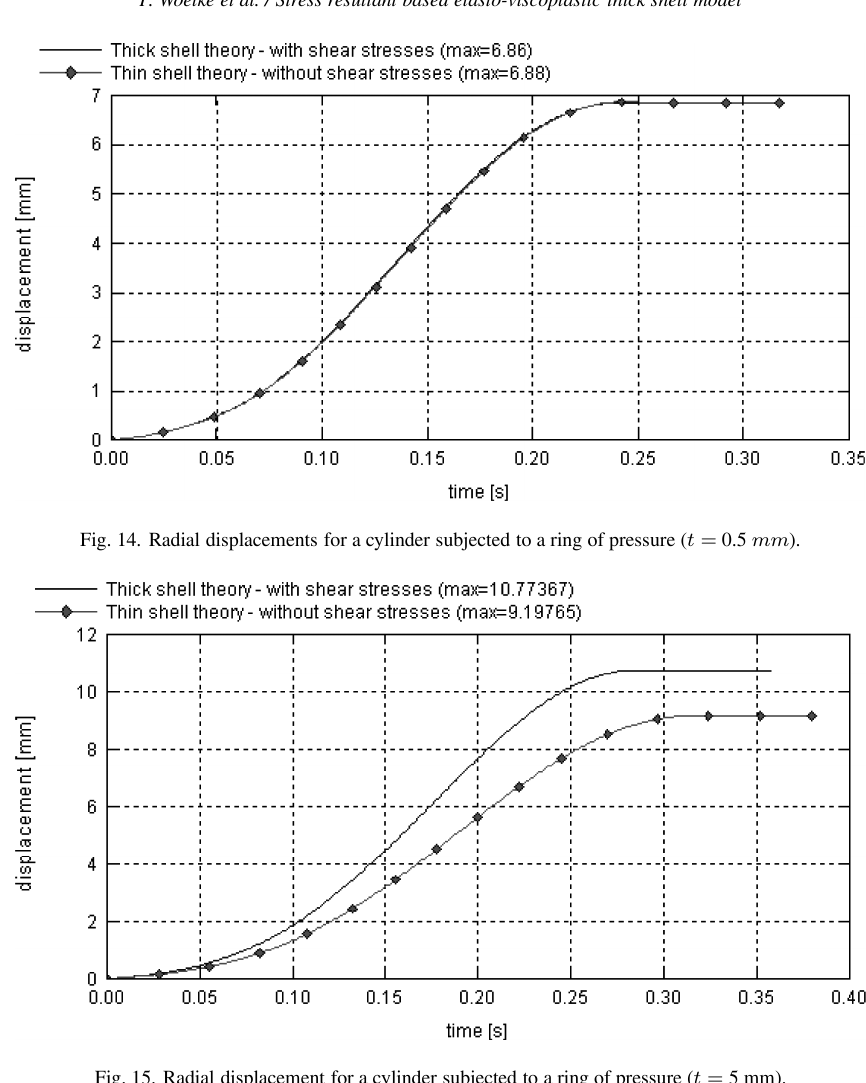
Fig. 15. Radial displacement for a cylinder subjected to a ring of pressure ( t = 5